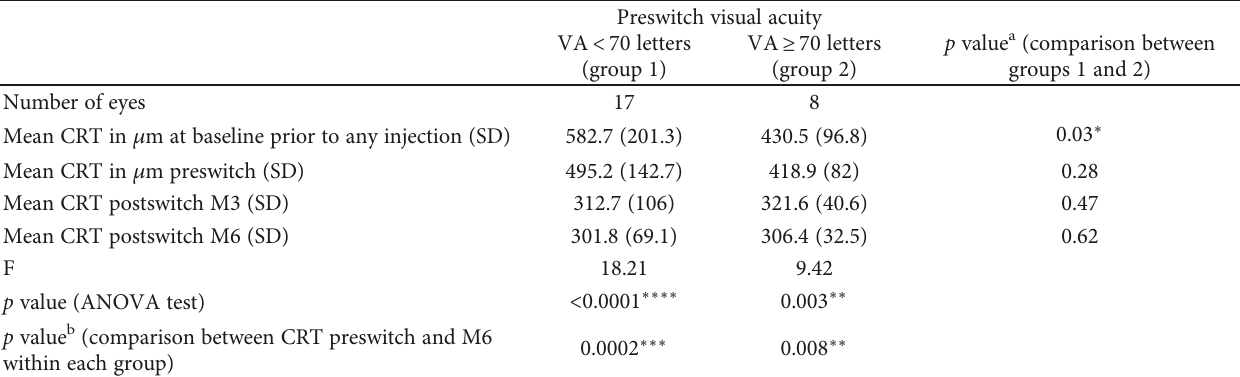
Table 6: Subgroup analysis of the impact of the preswitch VA ( < or ≥ 70 letters) on CRT.